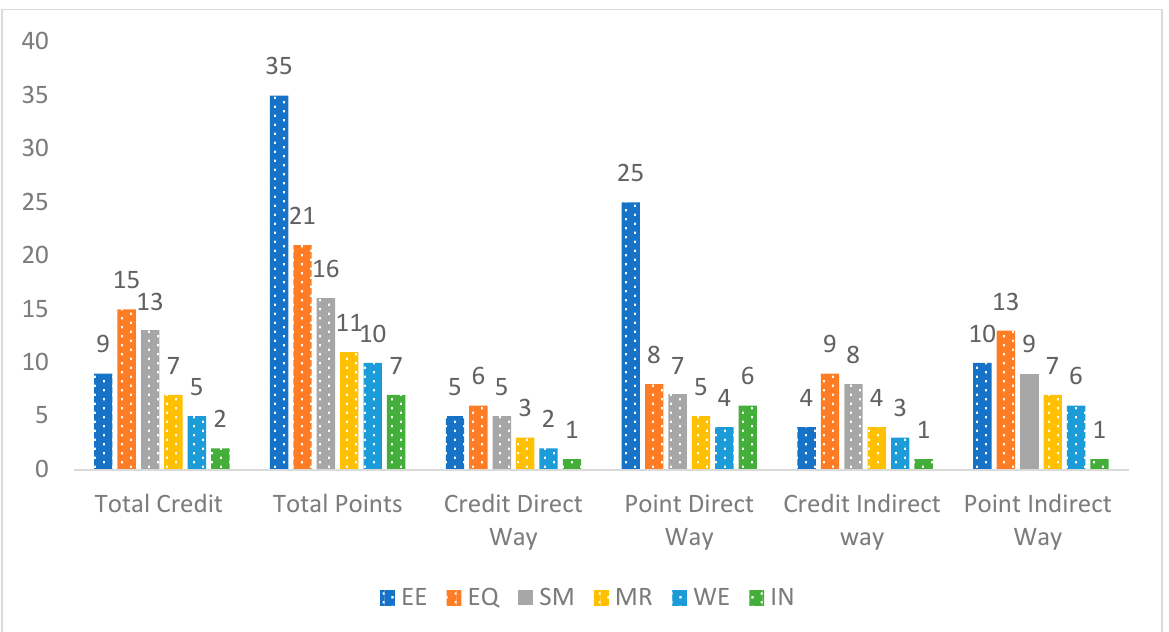
Figure 3. BIM Application Analysis Method.